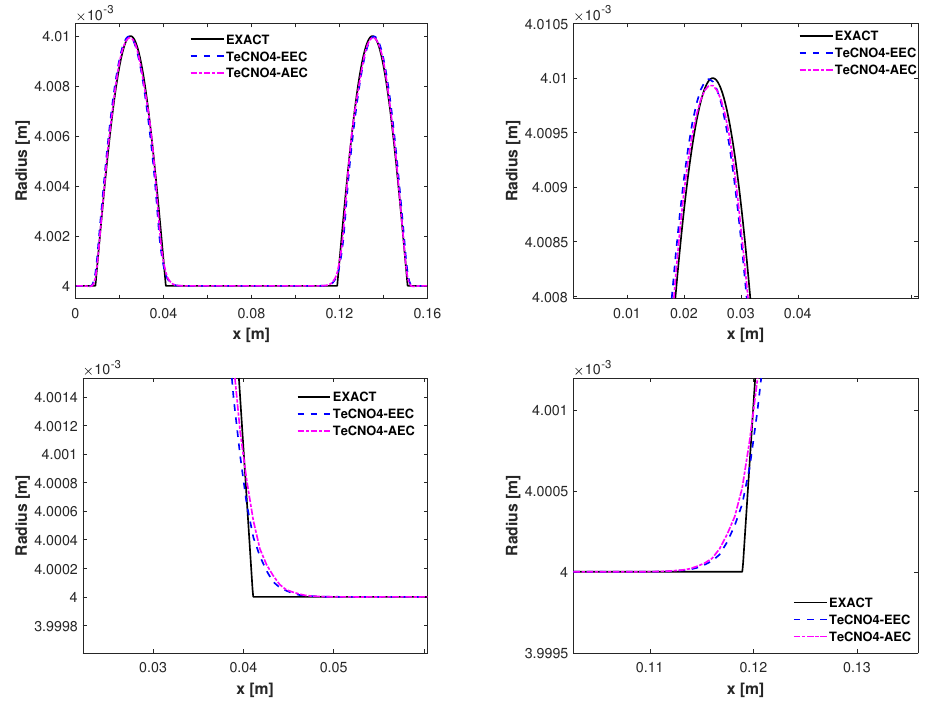
Figure 2. Example-2: Numerical solutions (for radius) of the wave equation at t = 0.004 s on a mesh with 200 cells with enlarged views in selected